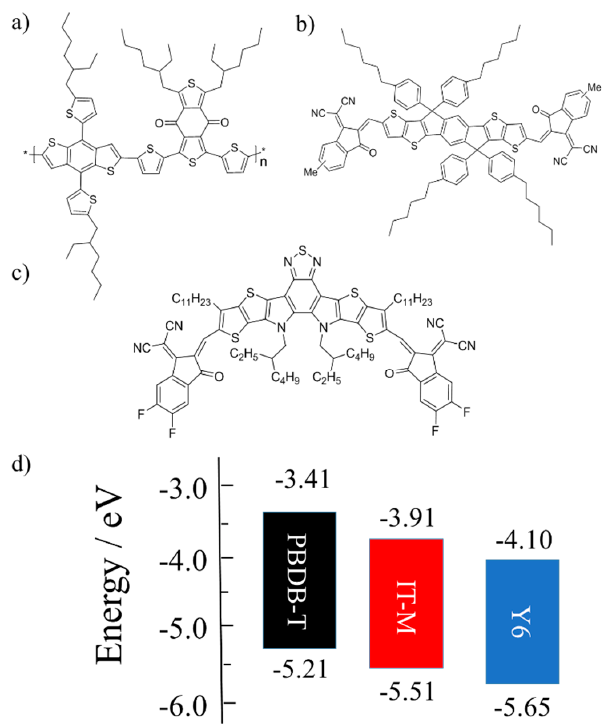
Figure 1. Chemical structures of materials employed in this study: ( a ) PBDB-T, ( b ) IT-M, and ( c ) Y6. ( d ) Energy level diagram of photovoltaic materials used in this study [11,18].